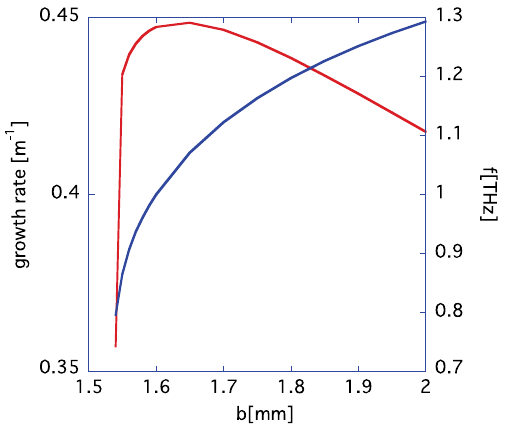
FIG. 2. The dependence of the growth rate (red) and the resonant frequency (blue) on the waveguide size b with 10 and Δ E=E ≃ 0 . 4% . The red and the blue R 0 ¼ 1 μ m, γ r ¼ curves are read by using the scale markings on the left and the right vertical axes, respectively.